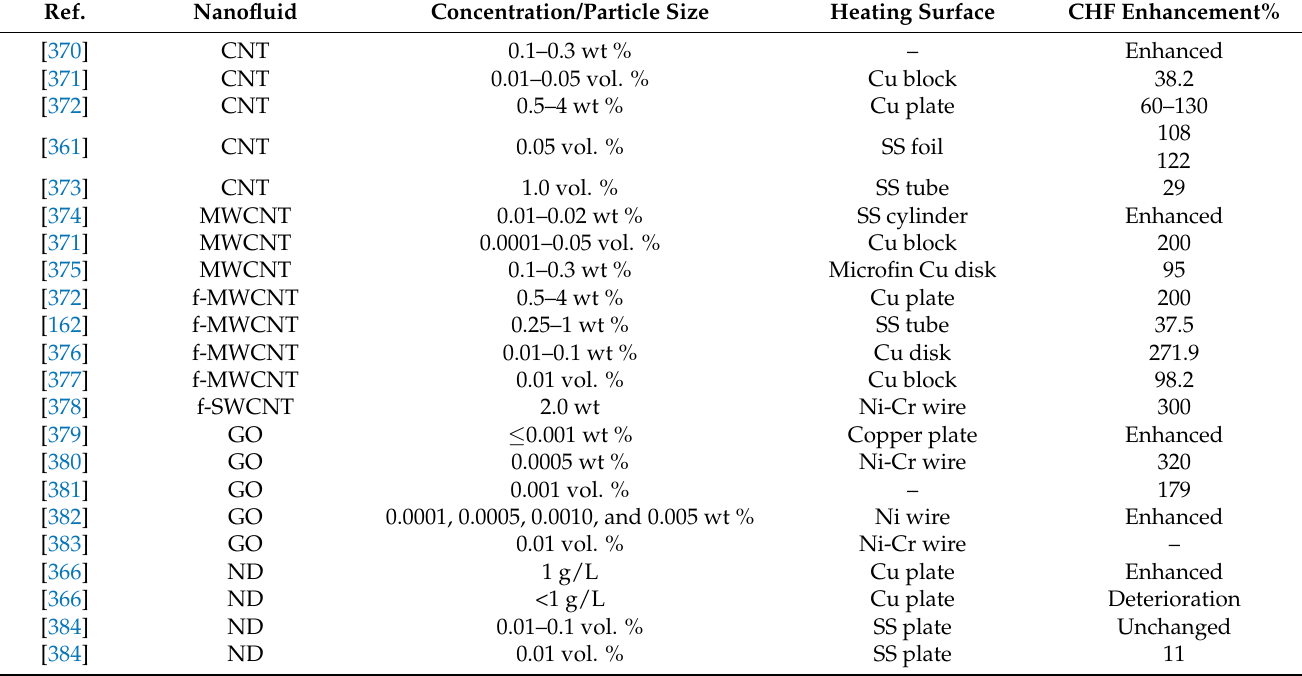
Table 7. Summary of selected CHF enhancement for various pool boiling studies in water base. Ref.